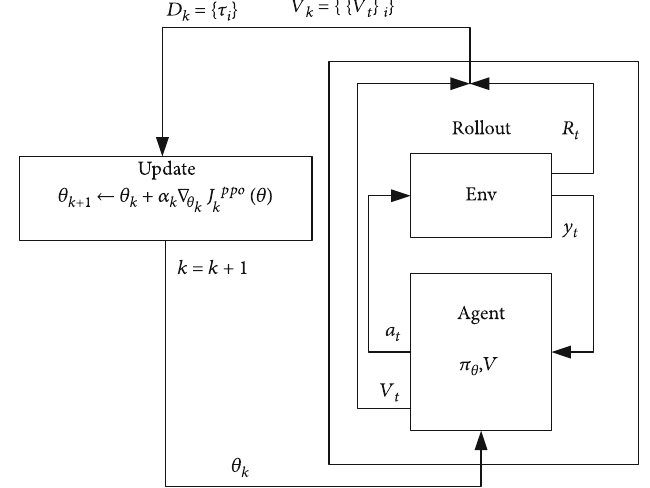
Figure 1: Training process by PPO [46]